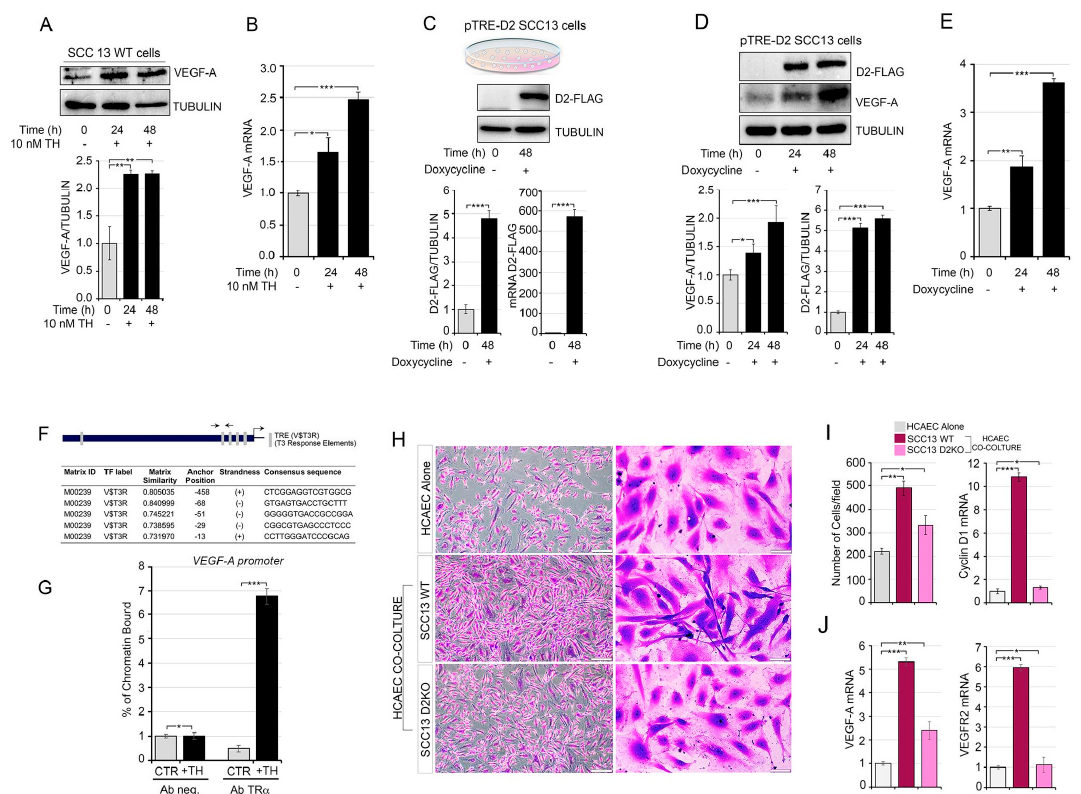
Figure 1. TH promotes VEGF-A secretion in SCC cancer cells and increases endothelial cell proliferation. ( A ) SCC13 cells were treated with 10 nM TH for 24 and 48 h. Total protein lysates were used for Western blot analysis of VEGF-A expression. Quantification of the VEGF-A protein levels versus tubulin levels is represented by a diagram (bottom). ( B ) mRNA levels of VEGF-A in SCC cells were treated as in ( A , C ). Schematic representation of the doxycycline treatment of pTRE-D2 SCC13 cells. D2-FLAG protein and D2 mRNA was evaluated by Western blot analysis and real-time PCR in pTRE-D2 SCC13 cells ± 2 μ g/mL doxycycline for 48 h (bottom). ( D ) Western blot analysis of VEGF-A and D2-FLAG expression was performed in pTRE-D2 SCC13 cells after doxycycline treatment for 24 and 48 h. Quantifications of the VEGF-A and D2-FLAG protein versus Tubulin levels are represented by diagrams (bottom). ( E ) mRNA levels of VEGF-A in pTRE-D2 SCC13 cells after D2 induction were measured by real-time PCR analysis. ( F ) Schematic representation of the human VEGF-A promoter and the potential TR binding sites identified by in silico analysis of the VEGF-A promoter and indicated in gray. The sequence of five consensus TR binding sites identified upstream of the transcriptional start site (TSS) is shown in the bottom panel. ( G ) Chromatin immunoprecipitation of TR binding to the VEGF-A promoter was performed in SCC13 cells treated or not with TH for 48 h. ( H ) The EC proliferation rate was evaluated by transwell assay; the images show the HCAEC cells labelled with crystal violet after 5 days of co-culture with SCC WT, SCC D2KO or alone. Scale bars represent 50 μ m. ( I ) Quantitative results (number of cells) of HCAEC transwell assay (left) and mRNA expression level of Cyclin D1 in HCAEC cells cultured as indicated in H (right). ( J ) mRNA expression of VEGF-A and VEGFR2 was measured in HCAEC cells cultured as indicated in H. Each experiment was done in triplicate. Results are expressed as mean ± SD. * p < 0.05, ** p < 0.01, *** p < 0.001.